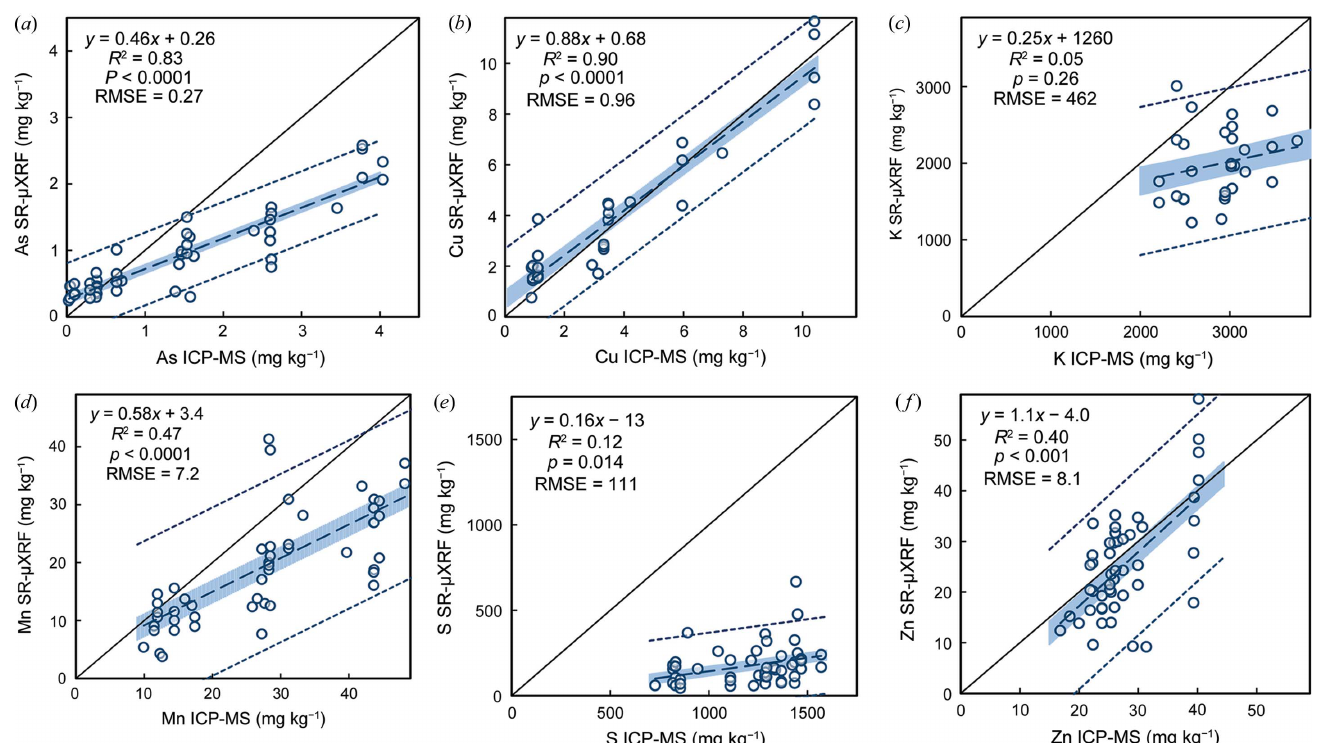
Figure 1 Simple linear regression fits between ICP-MS and SR- m XRF average elemental concentrations ( a ) As, ( b ) Cu, ( c ) K, ( d ) Mn, ( e ) S and ( f ) Zn in rice grains. The shaded region indicates the 95% confidence interval for the best-fit line. The dashed lines indicate the 95% prediction interval for the best-fit line. For K and Cu, n = 29; for all other elements, n =